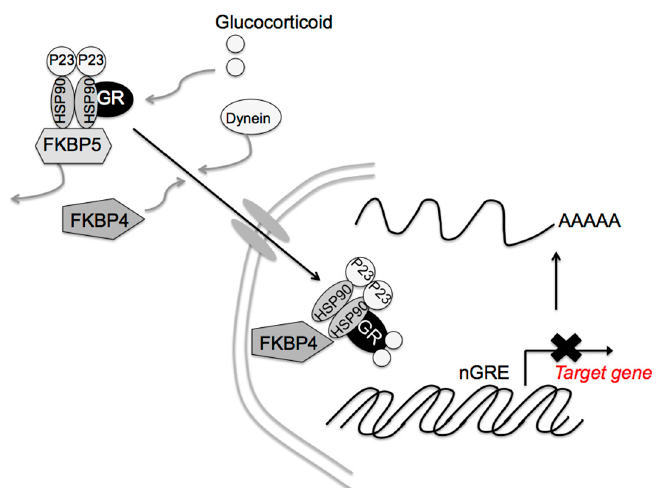
Figure 4. Proposed FK506-binding immunophilin 4 (FKBP4) and FKBP5 signaling mechanisms by glucocorticoids. After cortisol binding to the glucocorticoid receptor (GR), FKBP5 is replaced by FKBP4, resulting in complex translocation to the nucleus. Newly formed GR/heat shock protein 90 (HSP90)/FKBP4 complexes generally accumulate in the nucleus. The GR then modulates the target gene expression. [Modified from Ref. ([102], Int. J. Mol. Sci. 2021 , 22 , 5724.) with permission of the